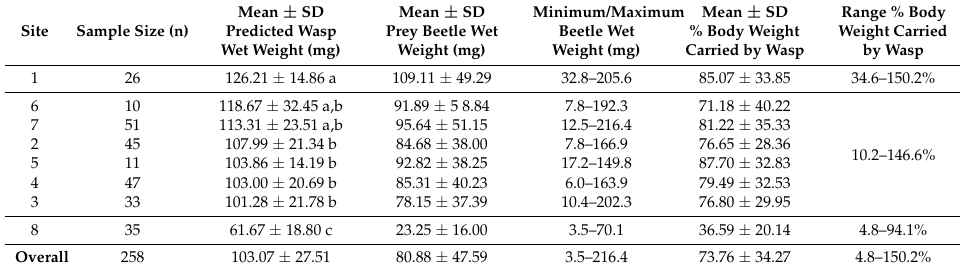
Table 2. Mean predicted wasp weight, prey weight, and prey load (% body weight: (beetle weight/wasp weight) × 100) at eight study sites in North Carolina. Site numbers are ordered by wasp weight; mean wasp weights followed by different letters are significantly different at p < 0.05.